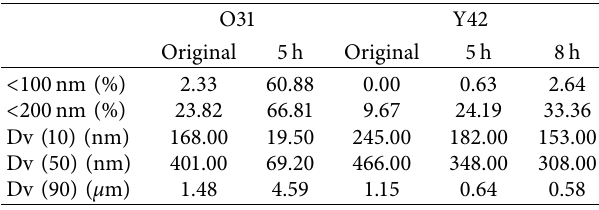
Table 4: Particle sizes of dyes with diferent types of structures under the same grinding process.